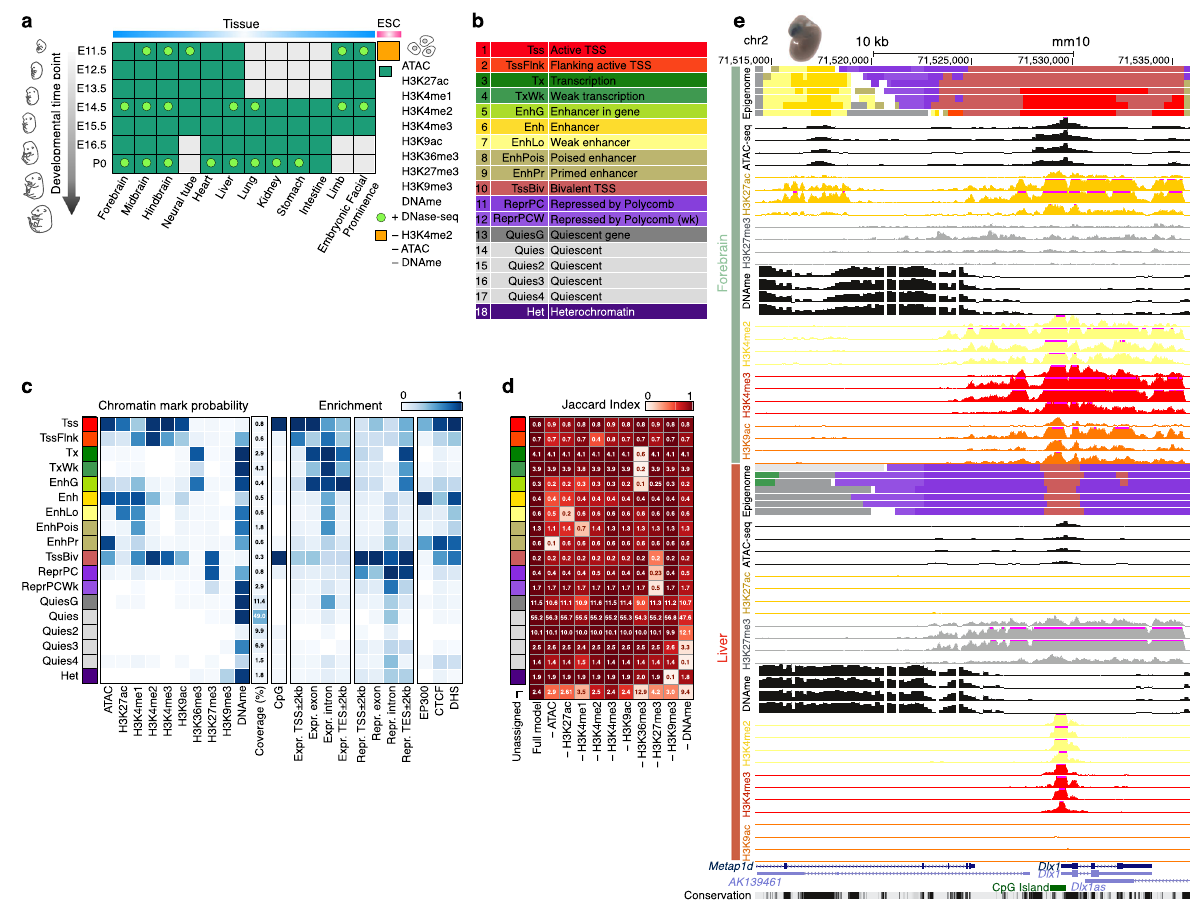
Fig. 1 Overview of the 66 epigenomes and 18 chromatin states during mouse embryogenesis. a Twelve tissues at 4 – 7 developmental timepoints have ChIP-seq data for eight histone marks (green boxes), ATAC-seq data, and DNA methylation (DNAme) data, totaling 66 complete epigenomes. Twenty- one of these epigenomes also have DNase-seq data (green dots). Embryonic stem cells (orange box) have ChIP-seq data for seven histone marks, and are missing H3K4me2, ATAC-seq, and DNAme. b Eighteen chromatin states are de fi ned by ChromHMM across the 66 complete epigenomes. c Histone-mark probabilities, genome coverage (averaged over 66 epigenomes, posterior probability > 0.5), and overlapping genomic features including gene expression, regulatory features (EP300 binding, CTCF binding, and DNase I hypersensitive sites), and distances to the TSSs of expressed and repressed genes are shown for each chromatin state. The enrichments for the categories are the averaged values across tissues and timepoints. d Jaccard similarities between the partial epigenomes with each mark omitted and the ten-mark E13.5 midbrain epigenome. e The Dlx1 locus is displayed with chromatin states (color- coded as in b ) in the forebrain and the liver for all seven timepoints. Also shown are the signals of several histone marks (scale: 0 – 50) that differ between forebrain and liver (for E11.5, E13.5, E15.5, and P0 only, due to space constraints), along with ATAC and DNA methylation signals. A transgenic mouse embryo is shown on top of the enhancer region, indicating the forebrain-speci fi c activity of this enhancer. A CpG island that overlaps with the bivalent region at the TSS of Dlx1 is shown at the bottom of the